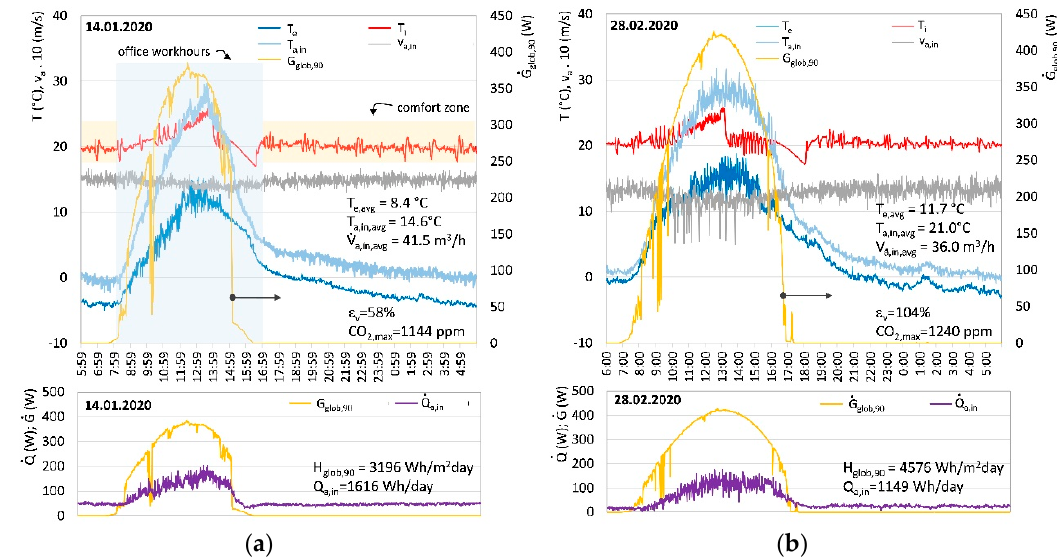
Figure 6. Graphs showing outdoor and indoor air temperatures and the temperature of supplied preheated air ( T e , T i , and T a,in ); velocity, ventilation air volume flow rate, and heat flux by preheated air ( v a , , and , a in Q ); average ventilation air temperature during office occupant hours T a,in,avg ; air preheating efficiency ( ε v ); as well as solar irradiation G glob, 90 ; and diurnal solar radiation H glob,90 ; as well as diurnal heat transferred into the ventilated space by preheated air Q a,in ; ( a ) for 14 th January 2020 and ( b ) for 28 th February 2020.